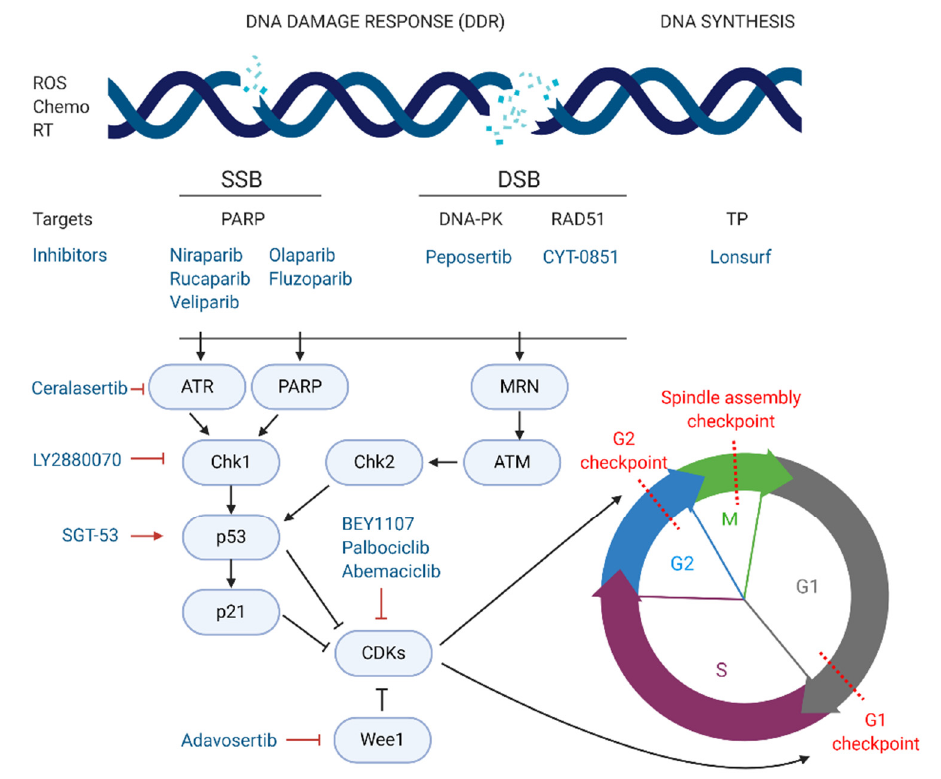
Figure 3. Inhibitors of DNA damage response and cell cycle arrest currently in phase II or III for pancreatic cancer treatment. DDR, DNA, damage response; ROS, reactive oxygen species; Chemo, chemotherapy; RT, radiotherapy; SSB, single strand break; DSB, double strand break. Table 5. Current phase I/II, II and III clinical trials using PARP inhibitors for the treatment of pancreatic cancer. Drug